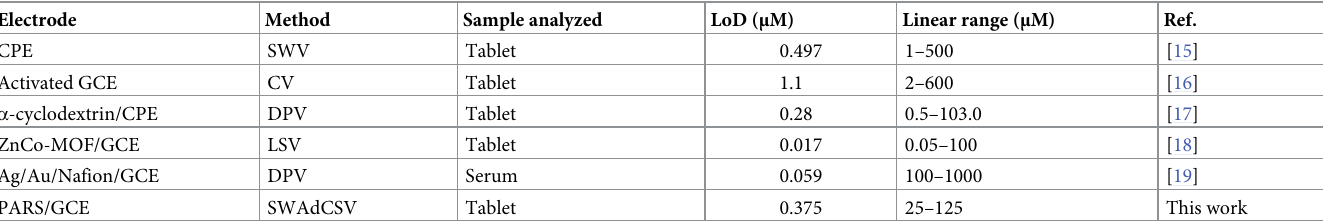
Table 3. Comparison of several electrochemical methods for MTZ